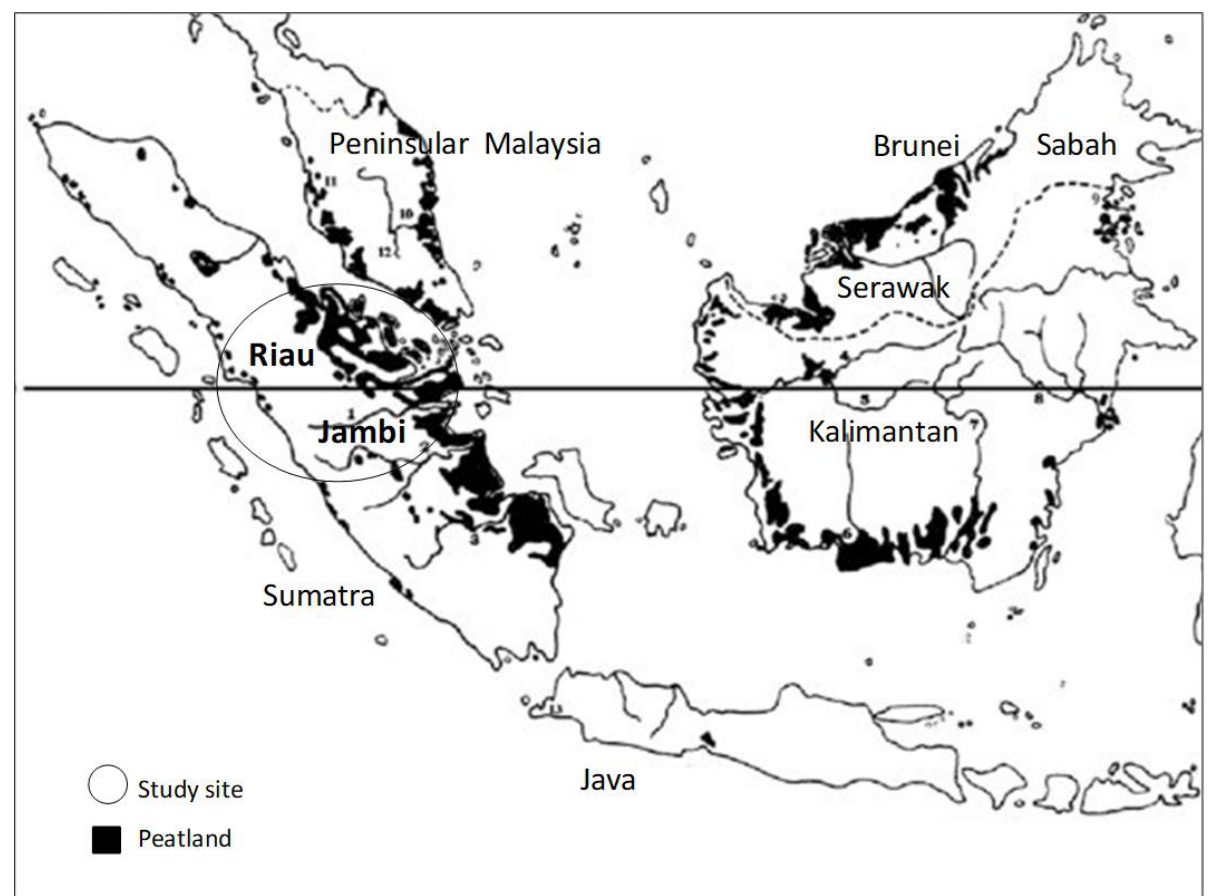
Figure 1. Map of the study site (revised from Posa et al.